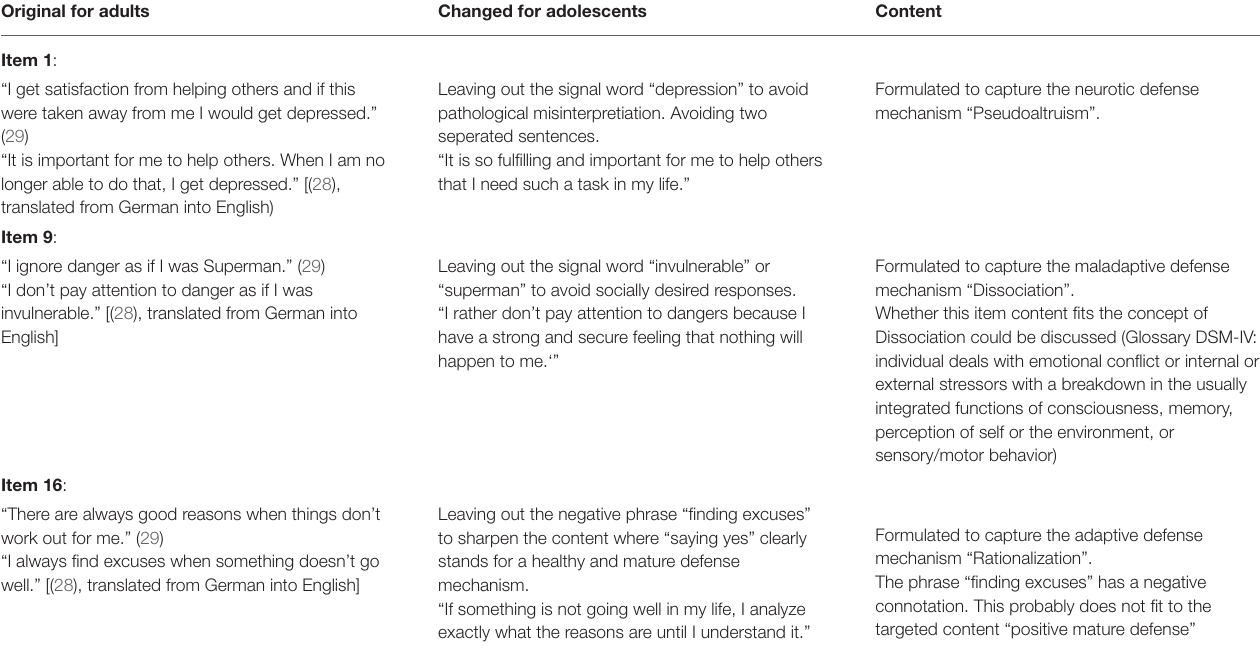
TABLE 1 | Examples and explanations for major changes of item formulations from adult to adolescent version of DSQ. Original for adults